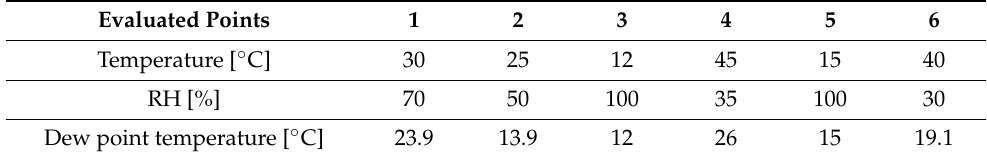
Table 1. Most representative AWGs working